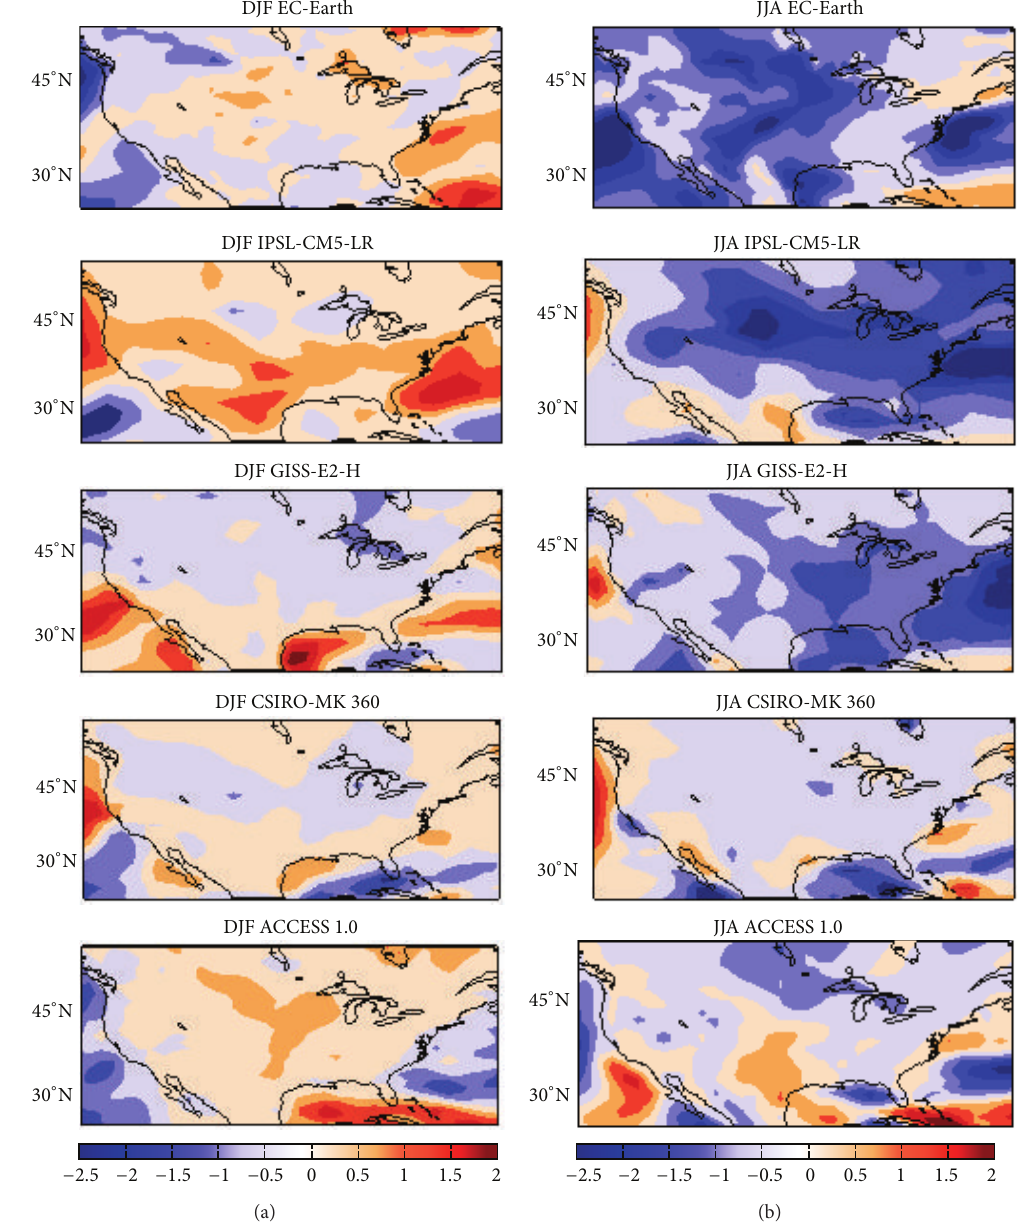
Figure 3: The trend [(2079–99) minus (1979–99)] in the surface wind speed over North America for winter (a) and summer (b), from five CMIP5 models as labeled at the top of each panel. The color scale, in m/s (per century), is shown at bottom. Blue and red indicate a decrease and an increase, respectively, in the surface wind